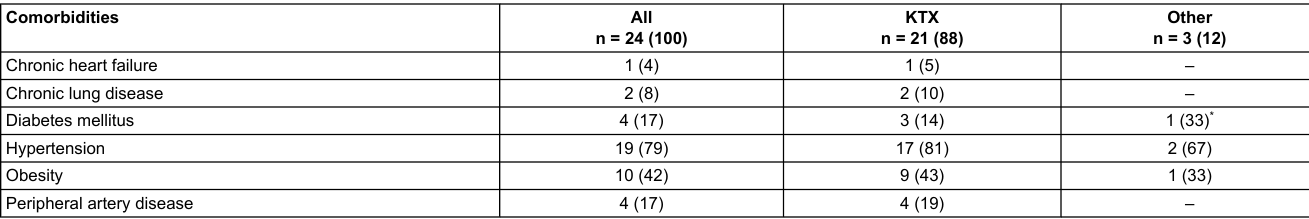
Table 1: Comorbidities of patients on the waiting list tested positive for SARS-CoV-2. Comorbidities